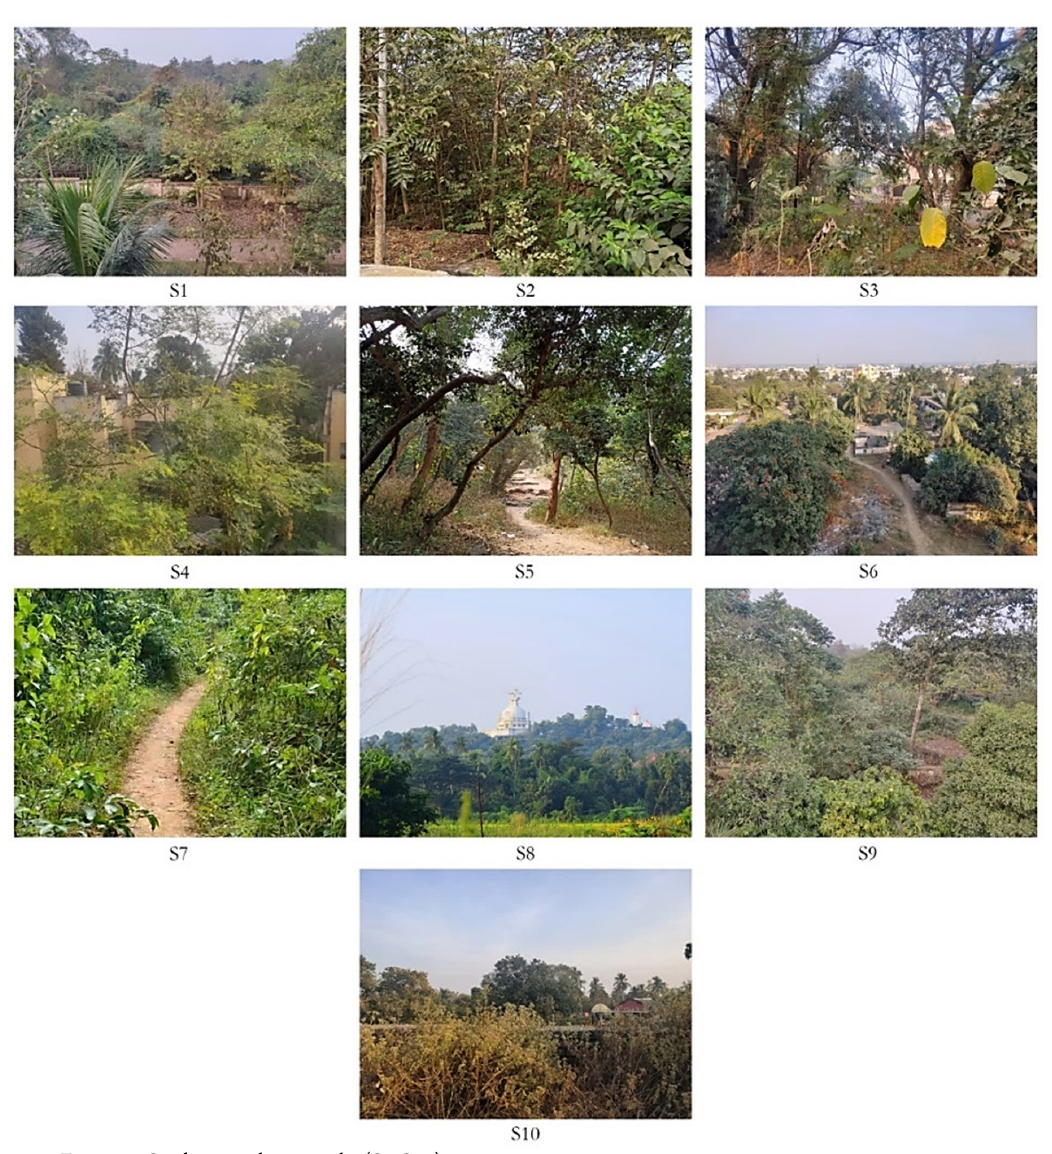
Figure 2. Study sites photographs